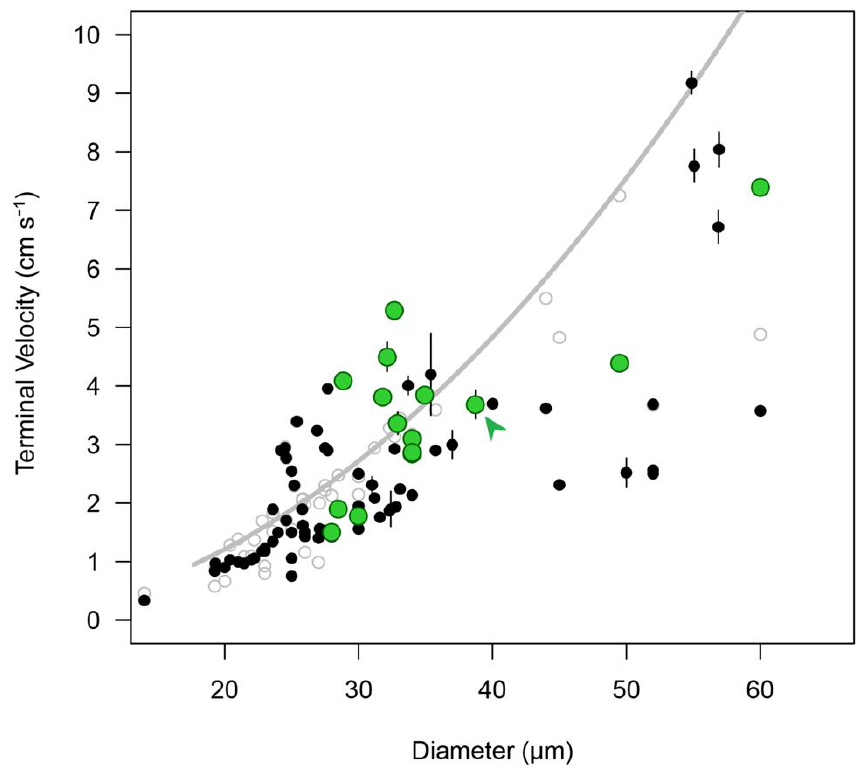
Figure 6. Settling velocities of angiosperm pollen grains either published in the literature (green dots are Poaceae, black dots are other families) or estimated from published diameters and densities (empty grey circles). The grey line indicates settling velocity values predicted by the Stokes' law when density is assumed to be 1 kg m-3 for a range of diameters. The green arrow indicates the settling velocity of D. obovata measured in this